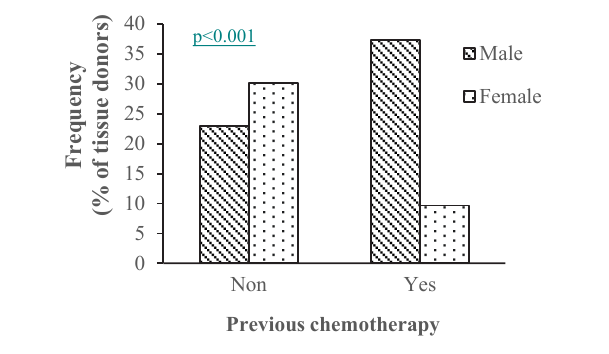
FIGURE 1 | Percentage of males and females in samples with/without previous chemotherapy treatment. p p -value of the Chi-squared test between variables sex and previous chemotheapy